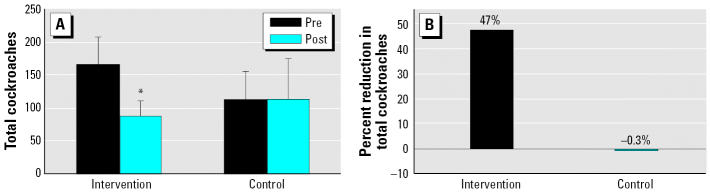
Cockroach infestation levels. (A) Mean (± SE) cockroaches (adults + nymphs) in traps collected over 2 weeks pre- (Pre) and postintervention (Post). Intervention group: preintervention (n = 22), post-intervention (n = 19); control group: preintervention (n = 14), postintervention (n = 6). (B) Percent reduction between total cockroaches in traps collected over 2 weeks pre- and postintervention. Intervention (n = 19), control (n = 6). Comparison of differences in percent reduction in pest infestation levels between the intervention and control groups, group t-test, p = 0.1 (B).*Wilcoxon signed-rank test, p = 0.016.